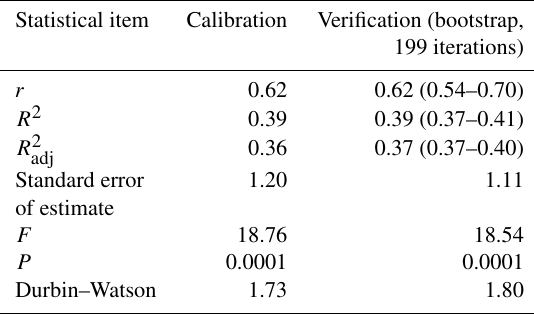
Table 2. Calibration and verification statistics of the reconstruction equation for the common period 1971–2003 of bootstrap. Statistical item